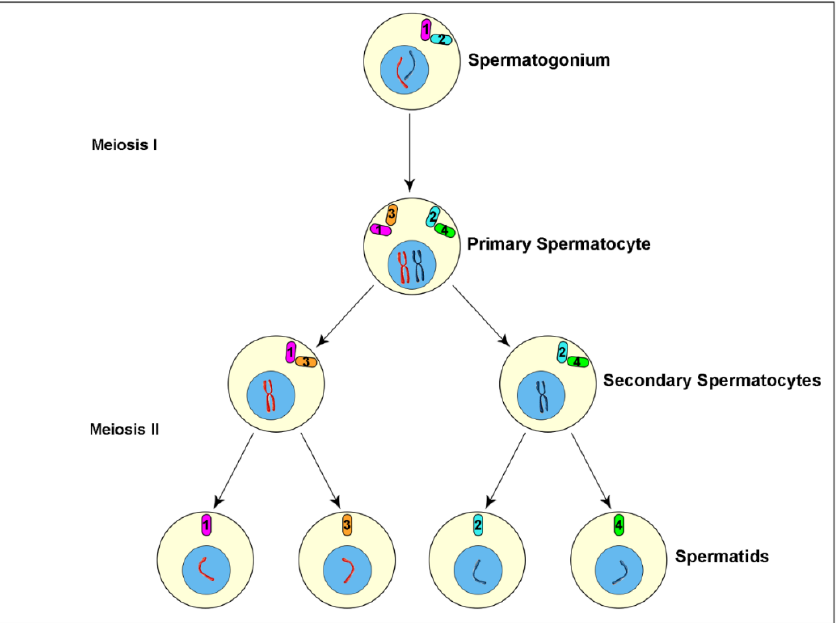
Figure 1. Cartoon of insect spermatogenesis depicting centriole and chromosome inheritance during the meiotic divisions. The four spermatids derived from each primary spermatocyte obtain centrioles that differ among them for their age and their parents. 1) Mother centriole; 2) Daughter centriole; 3) New daughter from the old mother; 4) New daughter from the old daughter.